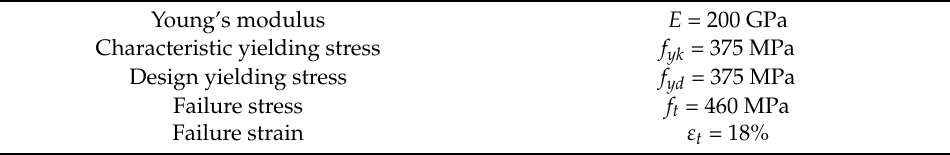
Table 1. Mechanical properties of concrete. Table 2. Mechanical properties of reinforcing